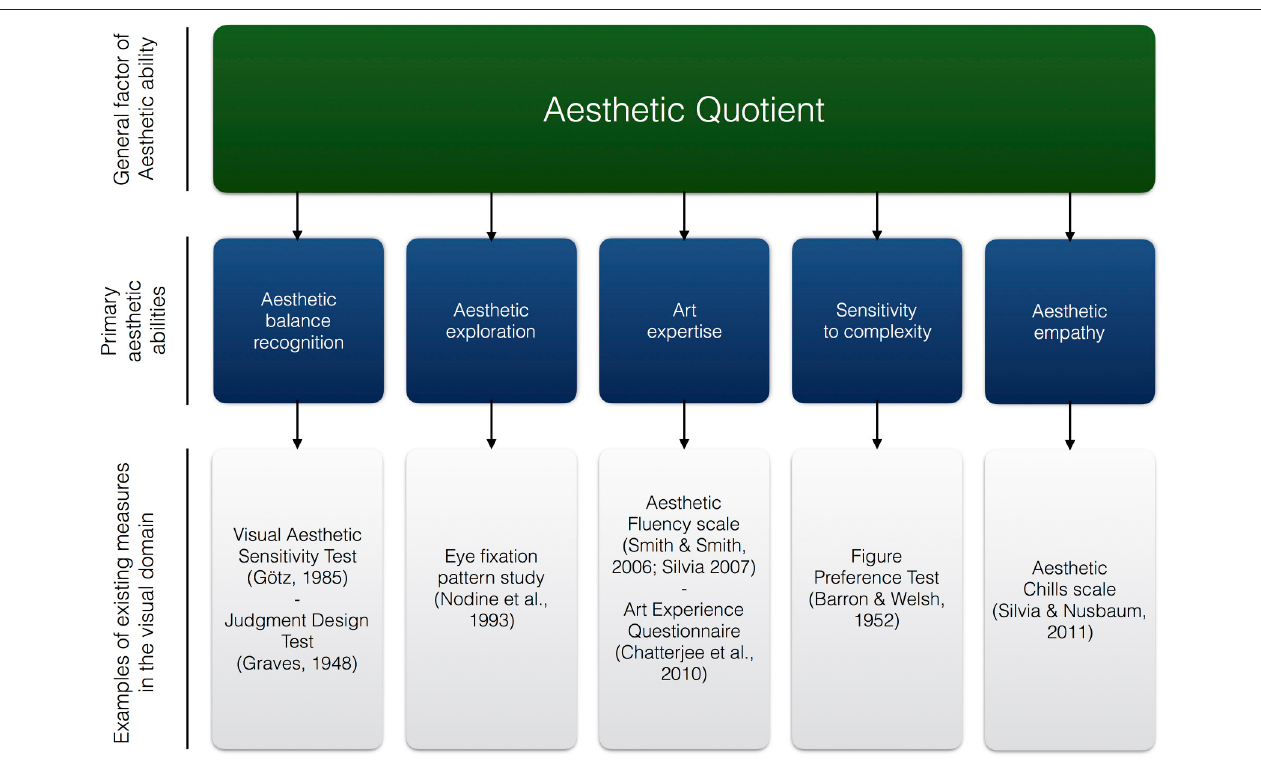
FIGURE 1 | Model for an Aesthetic Quotient approach of